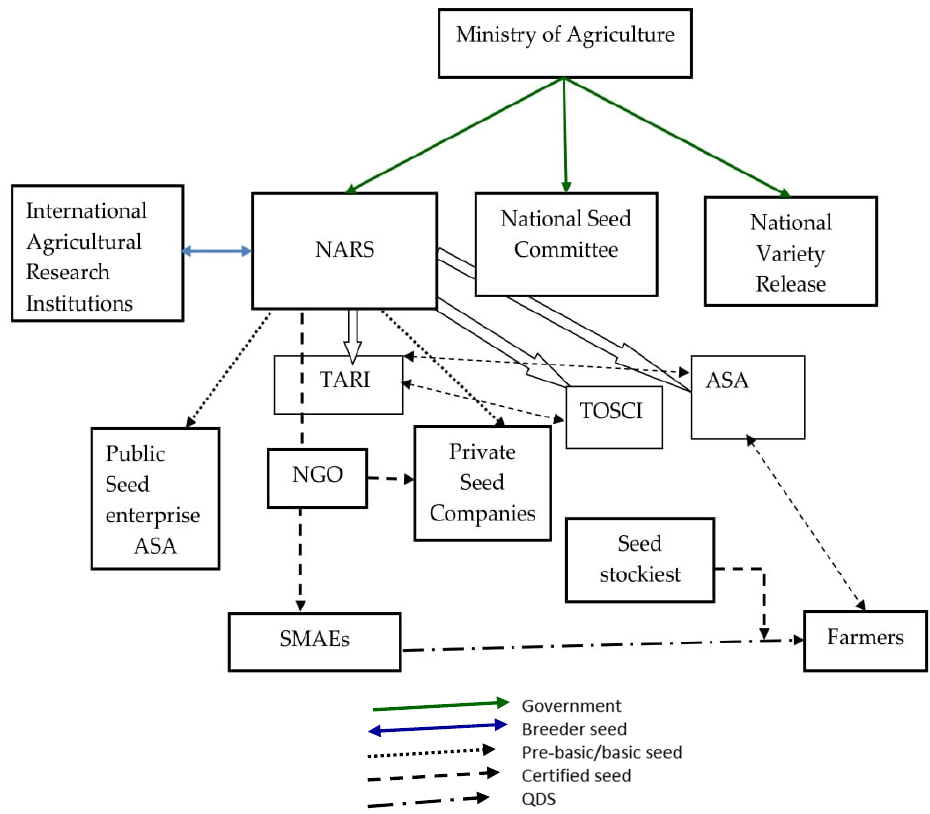
Figure 3. Main players and seed flow in the groundnut seed supply chain in